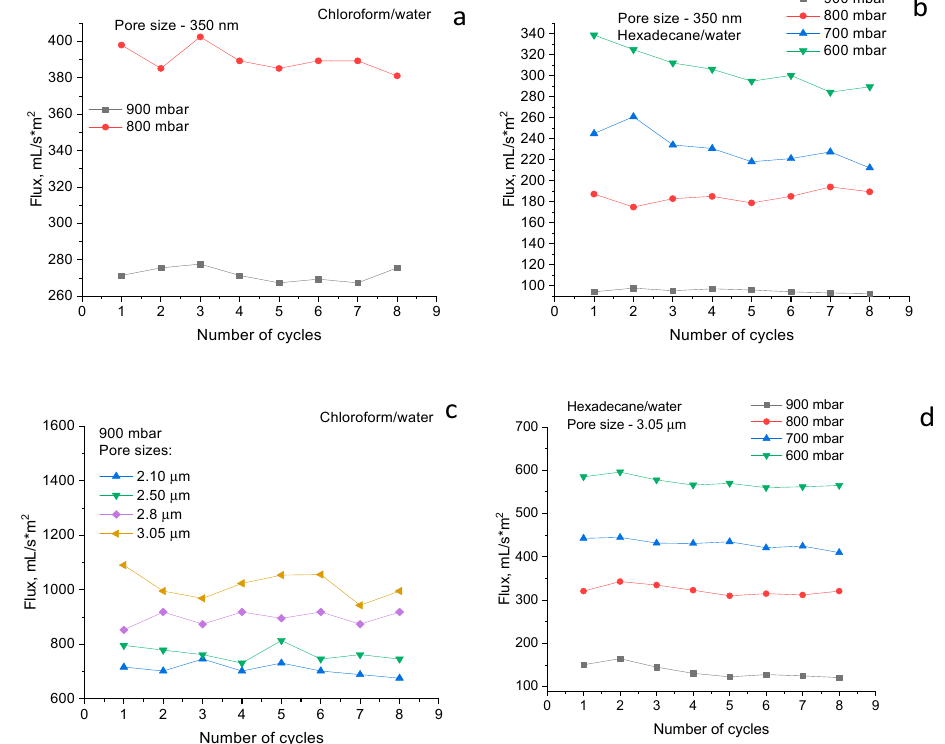
Figure 6. The fluxes of hydrophobic PET TeMs with pore density of 1 × 10 8 ( a , b ) and with pore density of 1 × 10 6 ( c , d ) for chloroform/water ( a , c ) and hexadecane/water ( b , d ) emulsions during 8 cycles of testing.